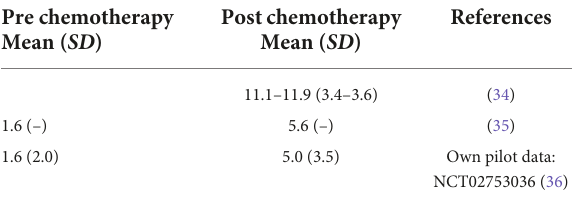
TABLE 1 Existing evidence for the placebo arm used for sample size